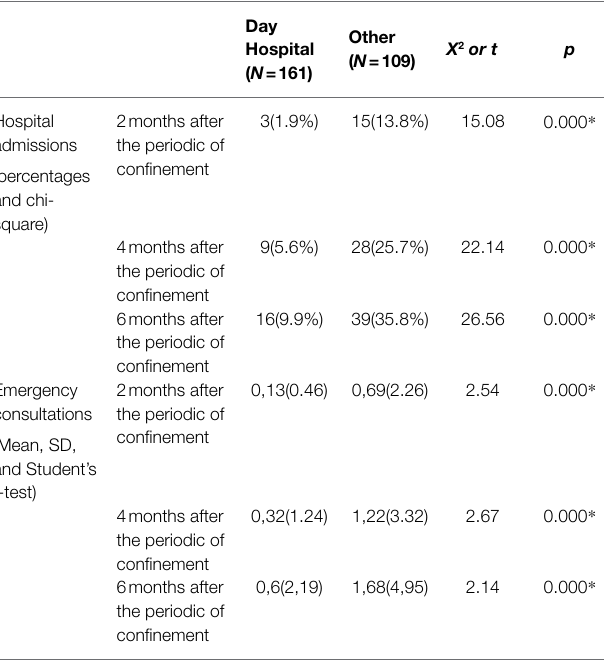
TABLE 3 | Comparison of admissions and emergencies among patients attended in DHs during lockdown and those attended in other